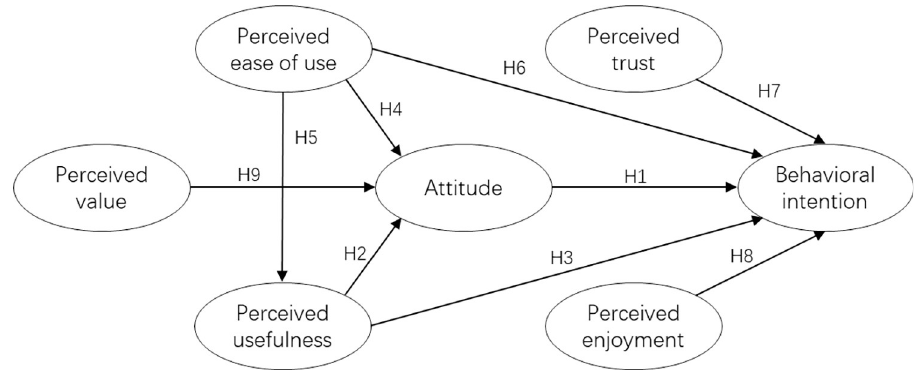
Fig 1. AVs technology acceptance